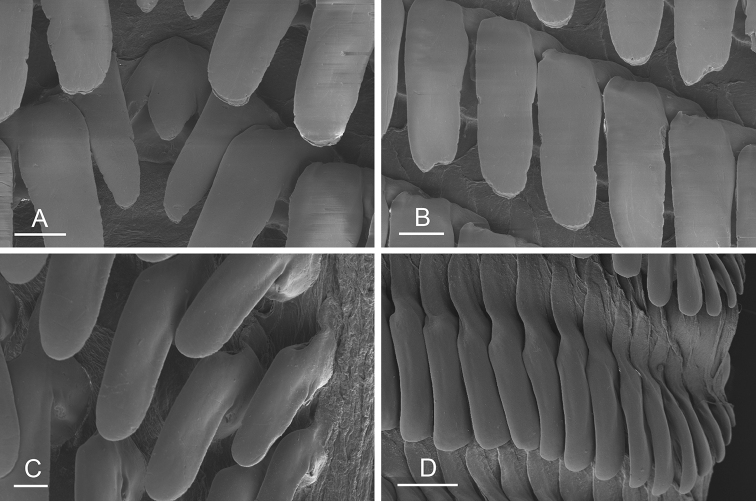
Radula, Peronia
verruculata (unit #4), Pakistan A–C [6164] (MNHN-IM-2019-1384) D [6165] (MNHN-IM-2019-1385) A rachidian and innermost lateral teeth B lateral teeth C outermost lateral teeth D outermost lateral teeth. Scale bars: 20 μm (A, B), 10 μm (C), 40 μm (D).